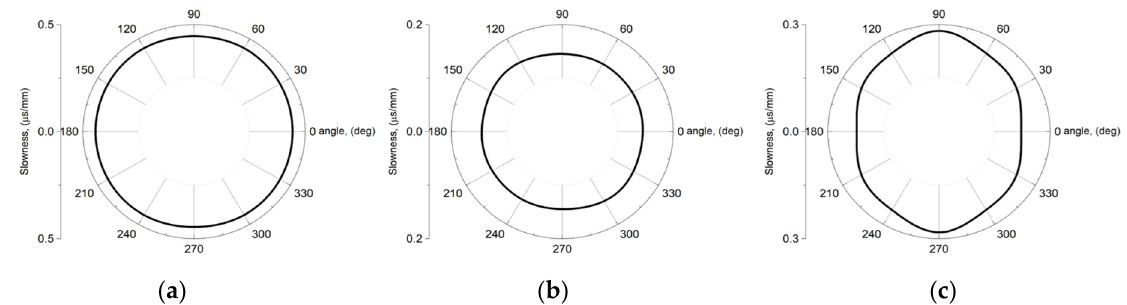
Figure 4. Slowness curves for acoustic plate waves in LiNbO 3 crystal: ( a ) A 0 wave at hf = 564 m/s on plane of 128Y-cut, ( b ) S 0 wave at hf = 1488.9 m/s on plane of Y-cut, ( c ) SH 0 wave at hf = 1300 m/s on plane of Y-cut. Zero angles 0 0 refer to Figure 2. h is the plate thickness.